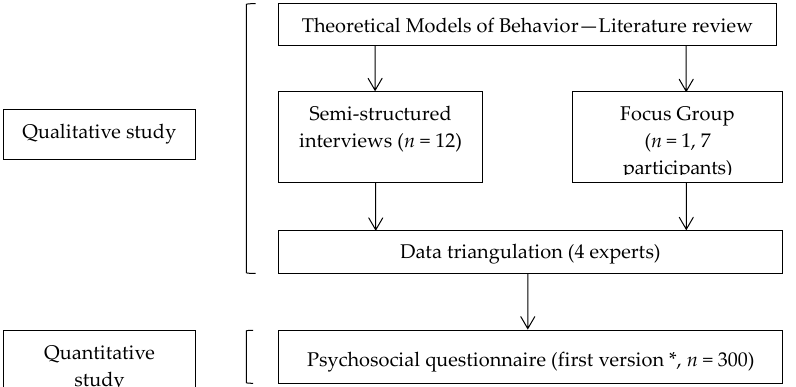
Figure 1. Main steps of the study [46]. * This part of the study deals with the validation step of the psychosocial questionnaire. An adjustment step was led later on 30